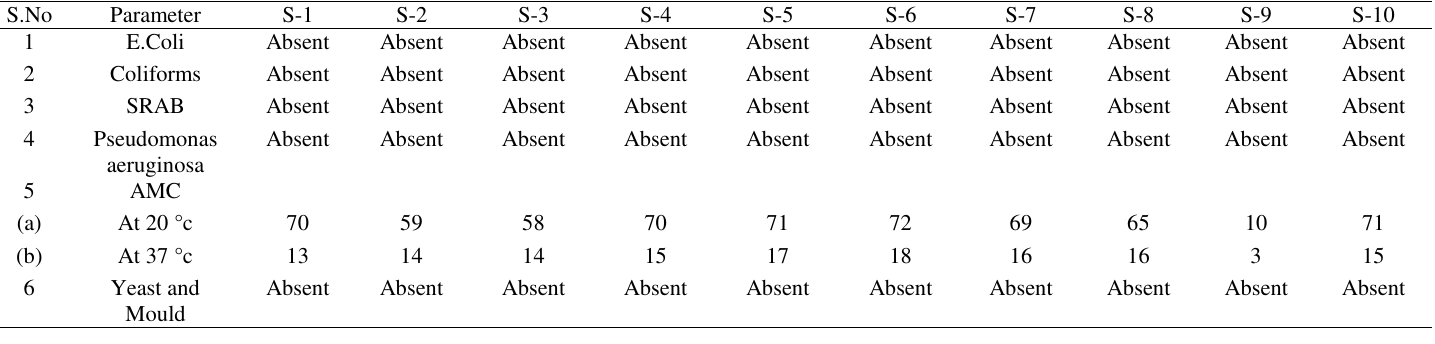
Table-6 Microbiological analysis report of Potable waters in AUGUST-2004 S.No